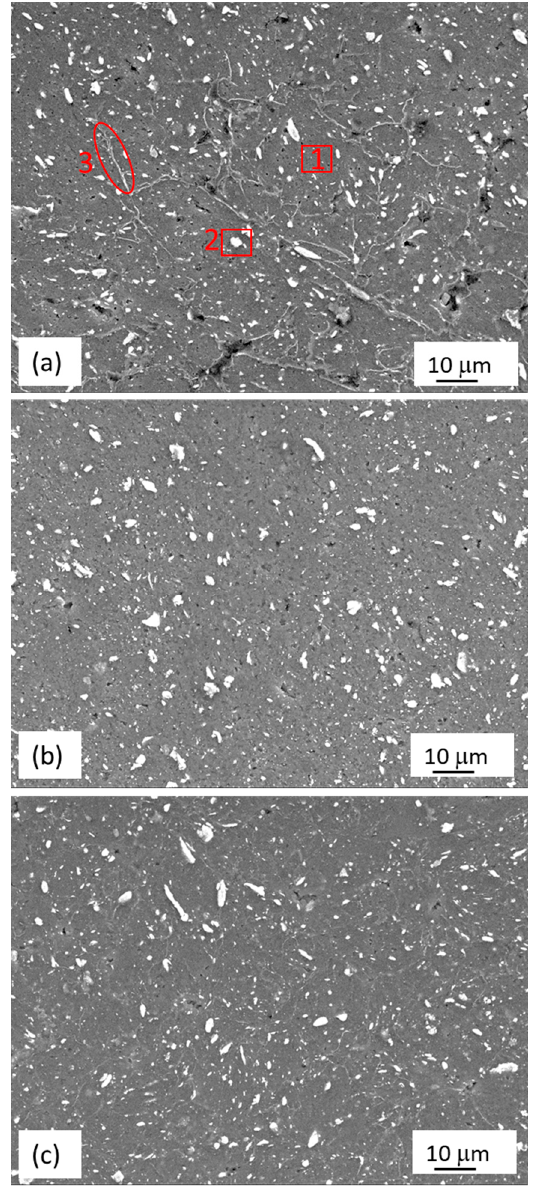
Figure 5. SEM micrograph of powder after compacting by ECAP route Bc for ( a ) one pass, ( b ) two 249 passes and ( c ) four passes. 250